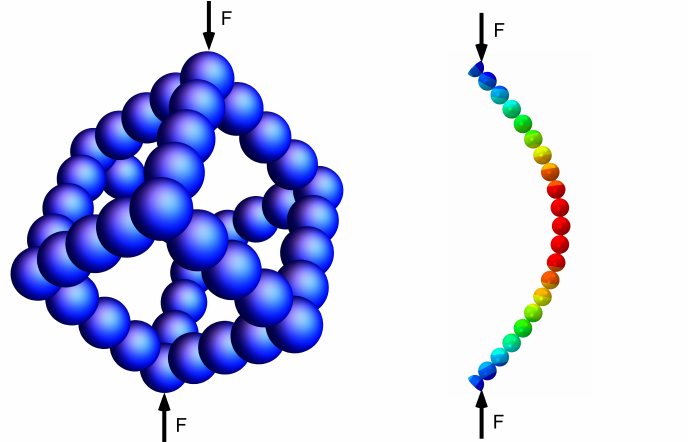
Figure 4. Scheme of a box made with overlapping spheres rotated such that at the top and bottom they can be loaded with a force F . This leads to a bending of the string of pearls at each edge, which is shown in the right figure (a finite element simulation discussed in Section 5). The spherical particles will resist such a deformation and stresses will develop at their necks. The necks act as local stress risers, which can be described by a notch